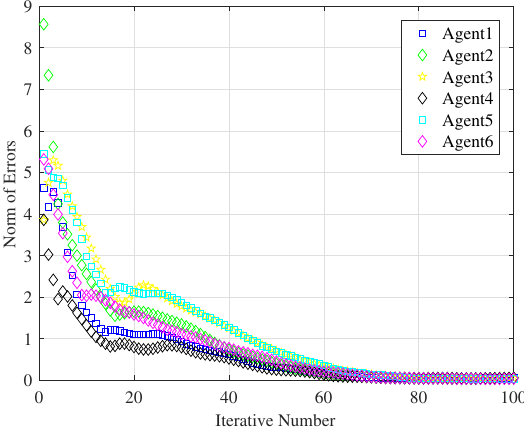
Figure 9. Tracking error of the model (34) with α =